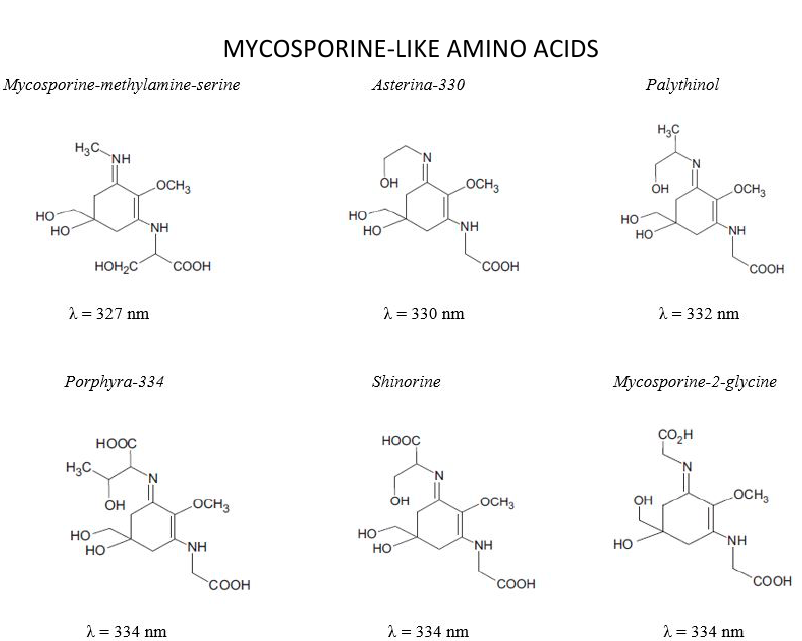
Figure 2. Identification, chemical structure and maximum absorption wavelengths ( λ max) of different MAAs.